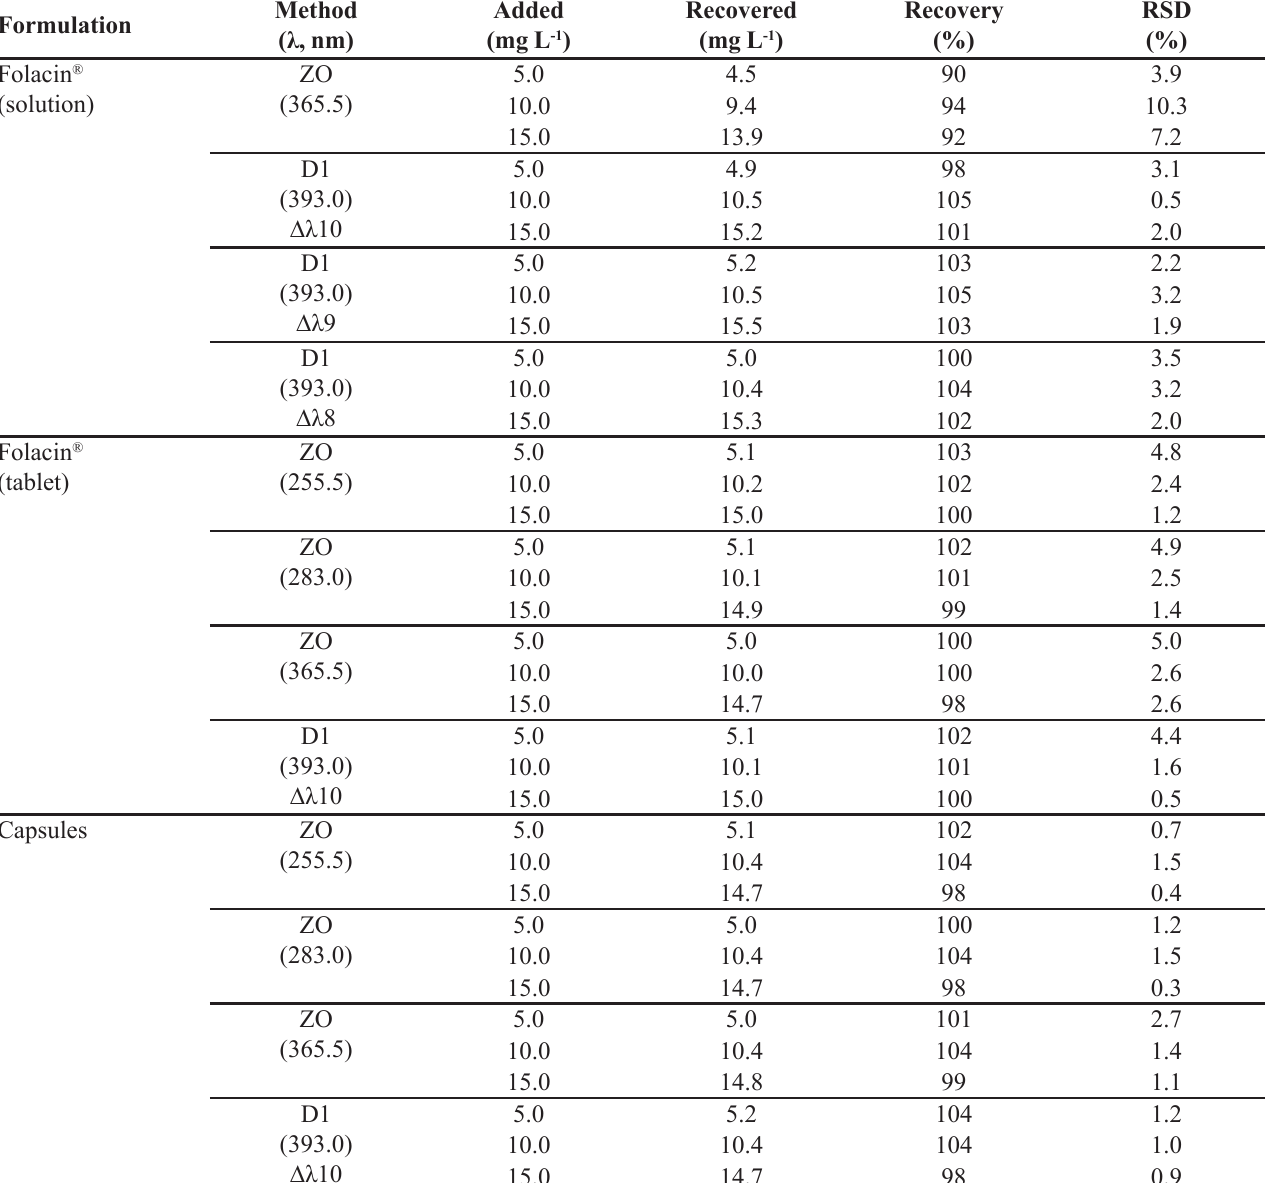
TABLE II – Results of accuracy tests for the samples at three concentration levels